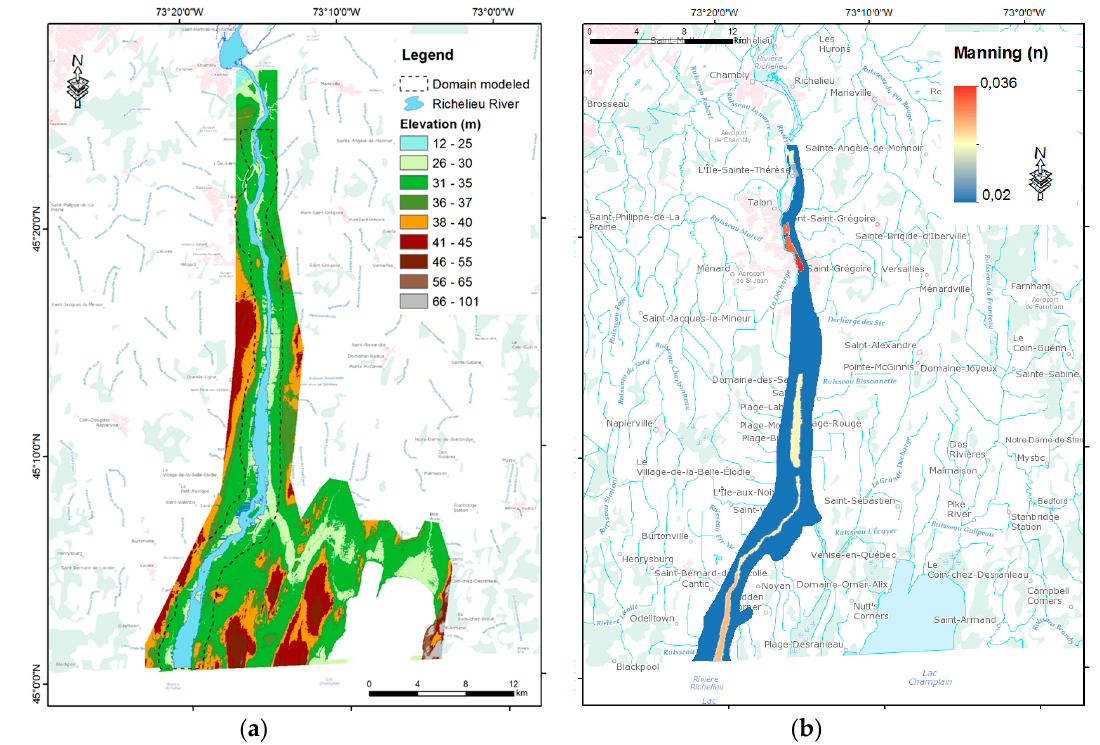
Figure 2. Digital Elevation Model (DEM) for the study area ( a ) and Manning’s n value for the studied river reach ( b ). river reach ( b